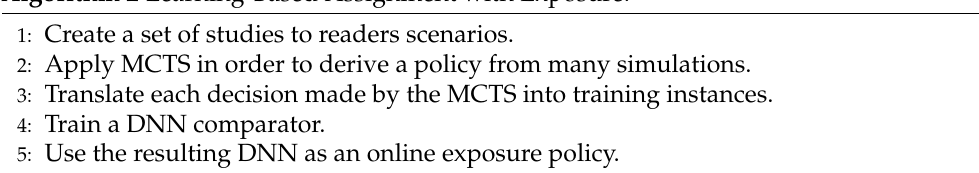
Algorithm 2 Learning-Based Assignment with